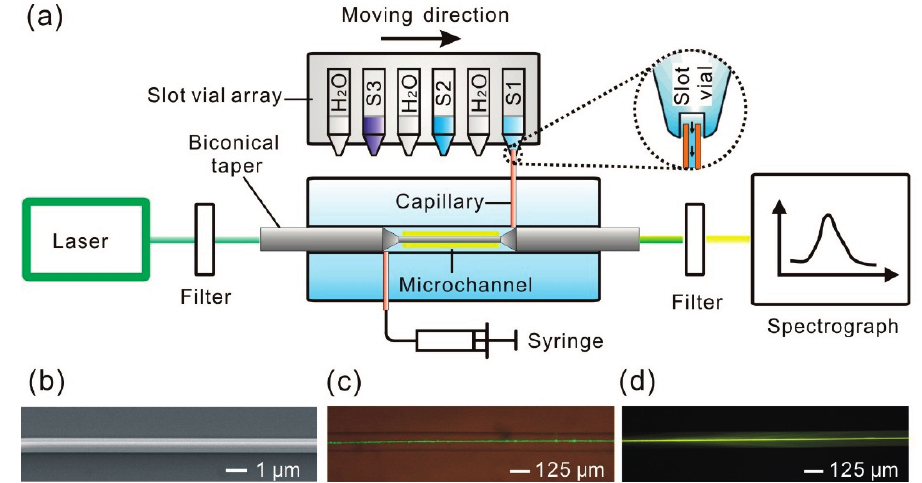
Figure 1. ( a ) Scheme of the experimental setup for biconical taper-based fluorescence sensing system; ( b ) Scanning electron microscopy image of a section of taper waist of 720 nm in diameter; ( c ) Optical micrograph of a 720 nm diameter taper waist guiding a laser with a wavelength of 532 nm embedded in a microchannel; ( d ) Optical micrograph of fluorescence excited by the evanescence field outside a 720 nm diameter taper